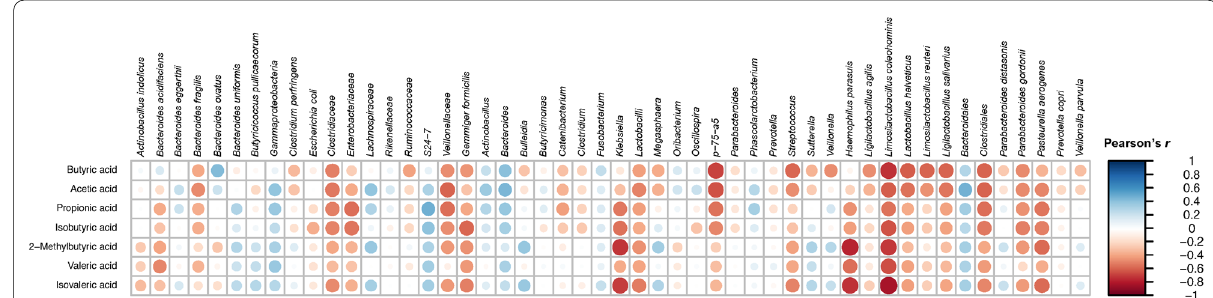
Fig. 6 Correlation (Pearson) between microbial taxa relative abundance and short- and branched- chain fatty acid concentrations. The minimal prevalence (among the sequenced samples) of one given microbial taxa is set to